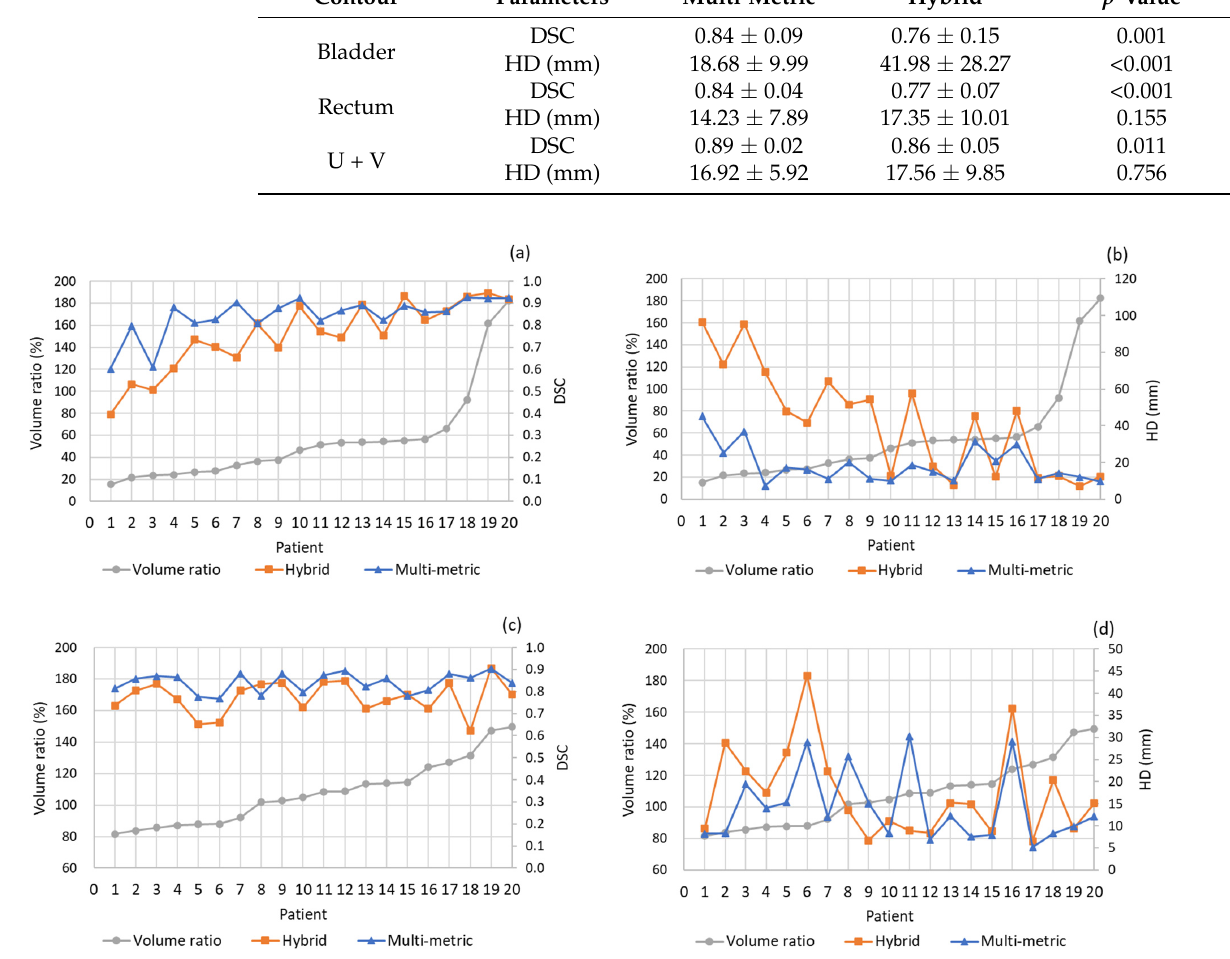
Figure 3. The changes of DSC ( a ) and HD ( b ) values with respect to the volume ratio of BT to EBRT for bladder and those ( c , d ) for rectum. Note that the orders of the patients between ( a , b ) and ( c , d ) are